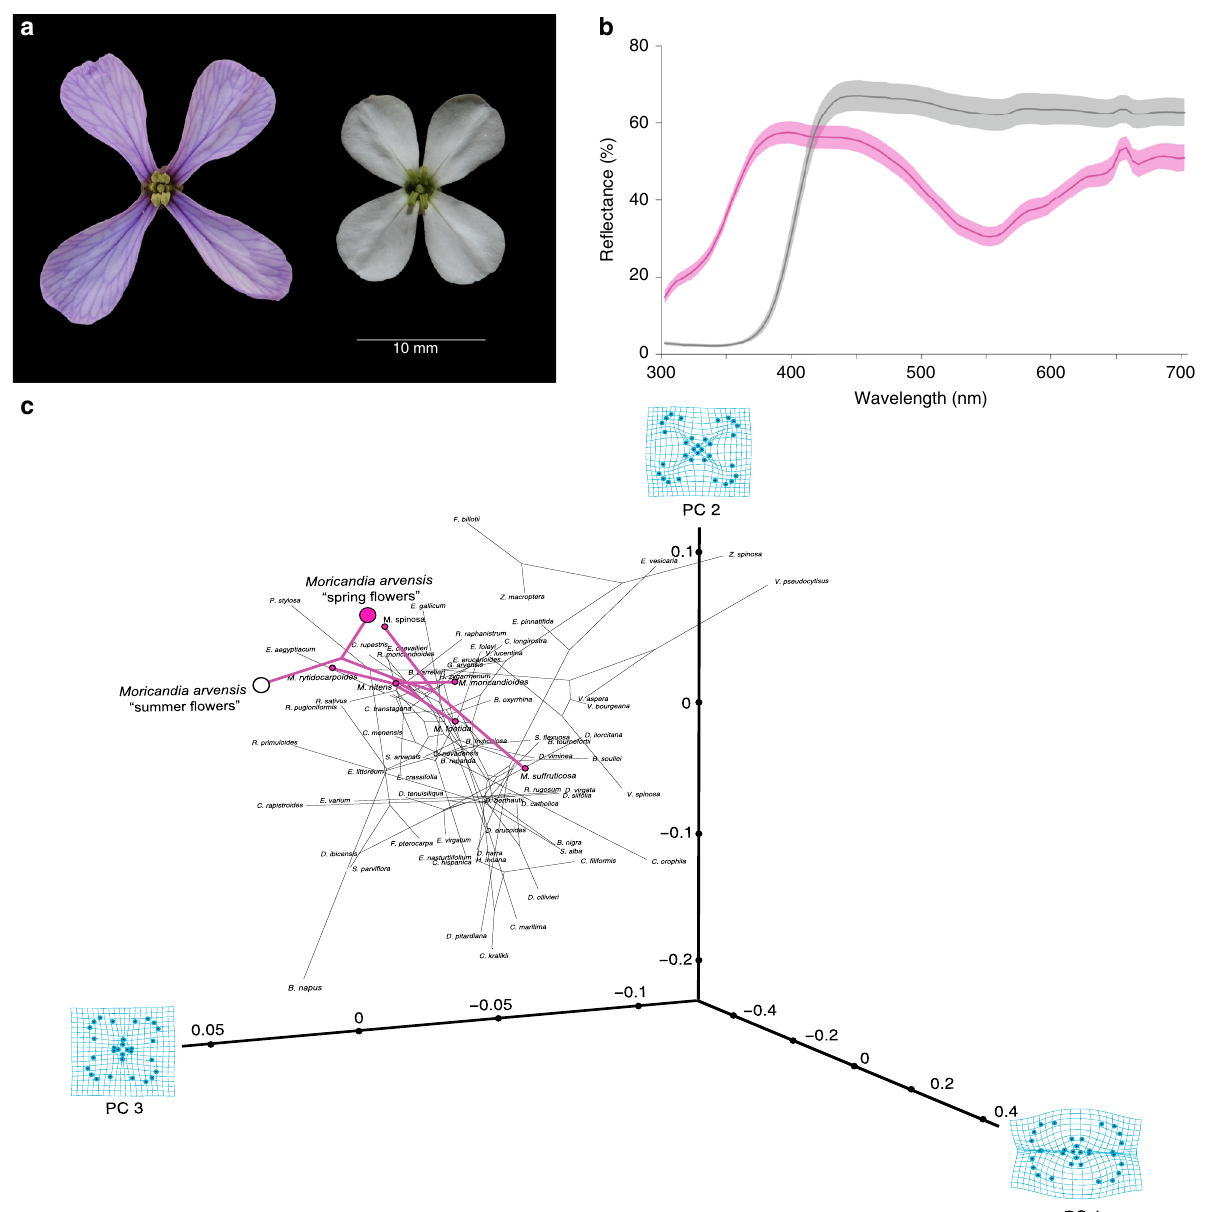
Fig. 2 Within-individual changes in fl oral traits. a Floral phenotype of a spring (left) and a summer (right) fl ower belonging to the same individual. Pictures were taken to the same individual in March and June 2018, respectively, in Malaha population (Granada province, Spain). b Average UV – Vis spectral re fl ectance of petals of spring (lilac line) and summer (grey line) fl owers. Shaded area represents standard errors ( n = 10 spring fl owers and 10 summer fl owers). c Phylomorphospace projection of the fi rst three principal components of the corolla shape onto the phylogeny of the Brassiceae tribe ( n = 72 species). It is shown the change in shape as deformation grids associated with extreme values of each component. The M. arvensis spring fl ower is shown as a large lilac dot and the M. arvensis summer fl ower as a large white dot. The Moricandia clade is shown in